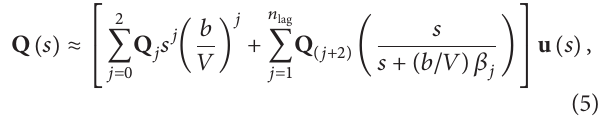
system with freeplay a modified 4th order Runge-Kutta algorithm using H´enon method is used. H´enon method is necessary in order to identify changes in the stiffness due to the freeplay. This approach is used to minimize